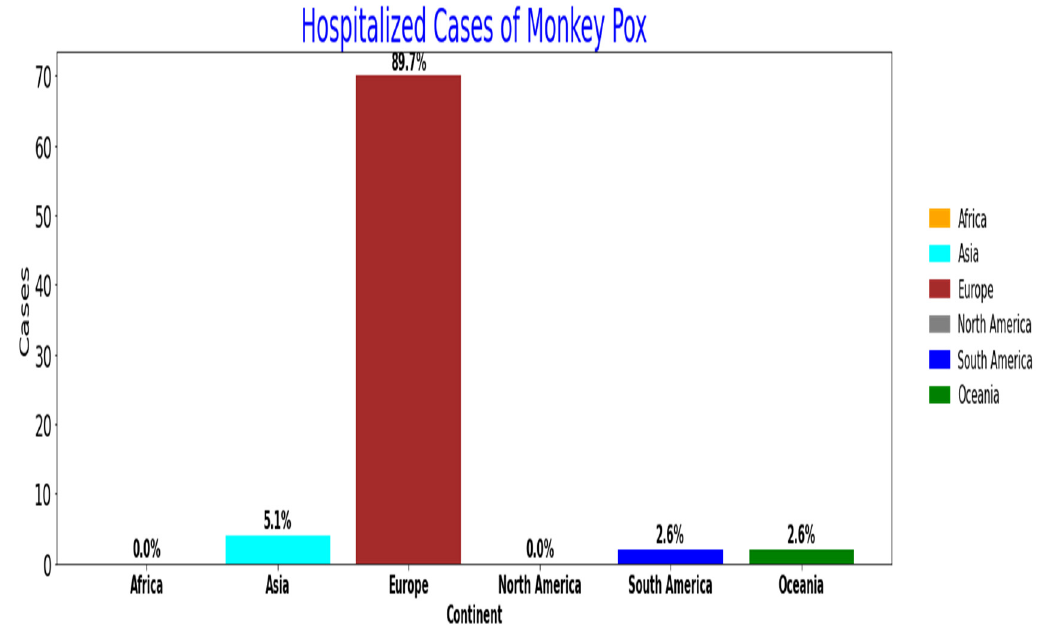
Figure 2. Hospitalized Cases of Monkey Pox.